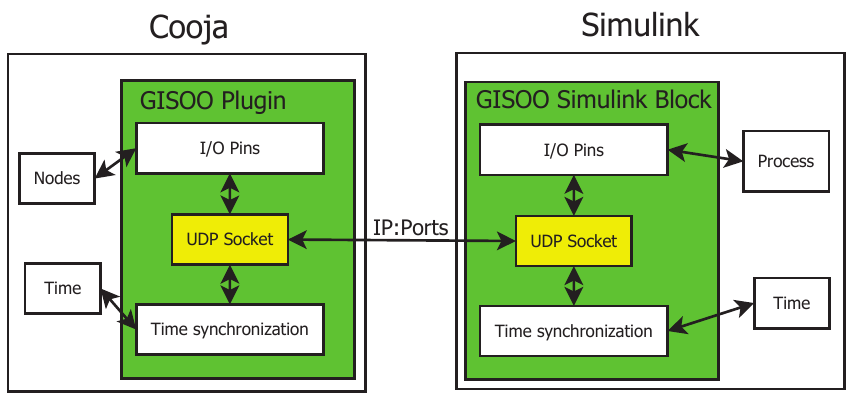
Figure 5. Communication between GISOO and